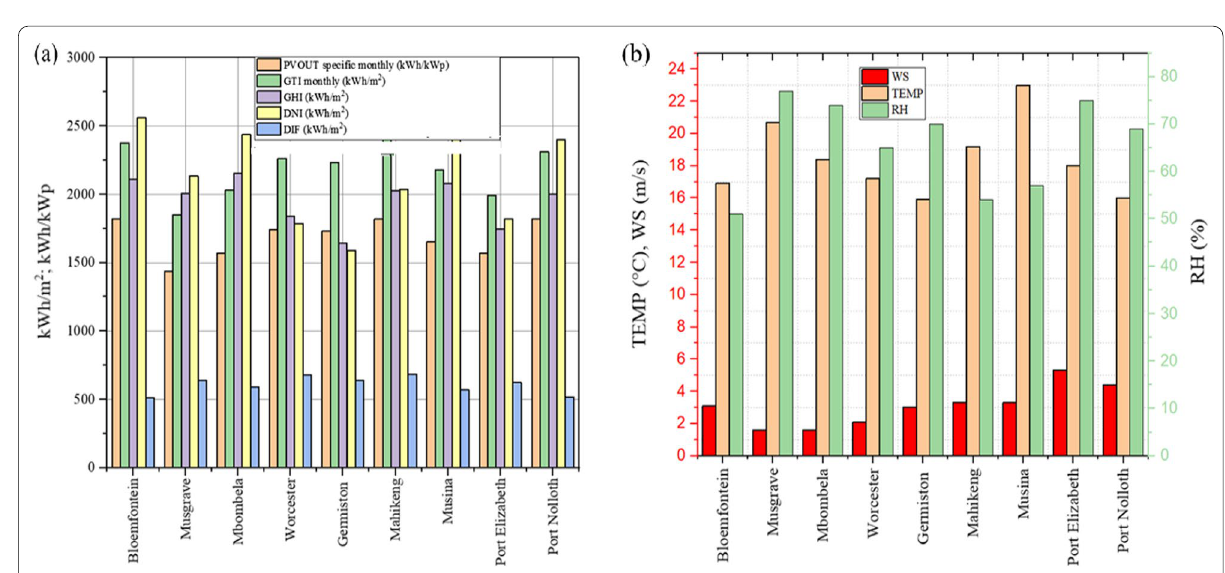
Fig. 9 Selected locations’ a PV power potential, b PV power output limiting